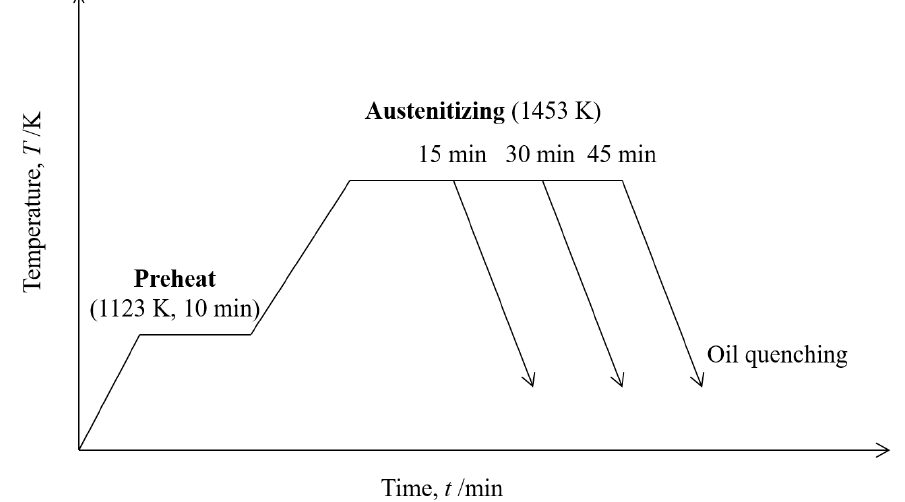
Figure 2. Experimental process for the investigation of effect of holding time on the microstructure of AISI M42 HSS.